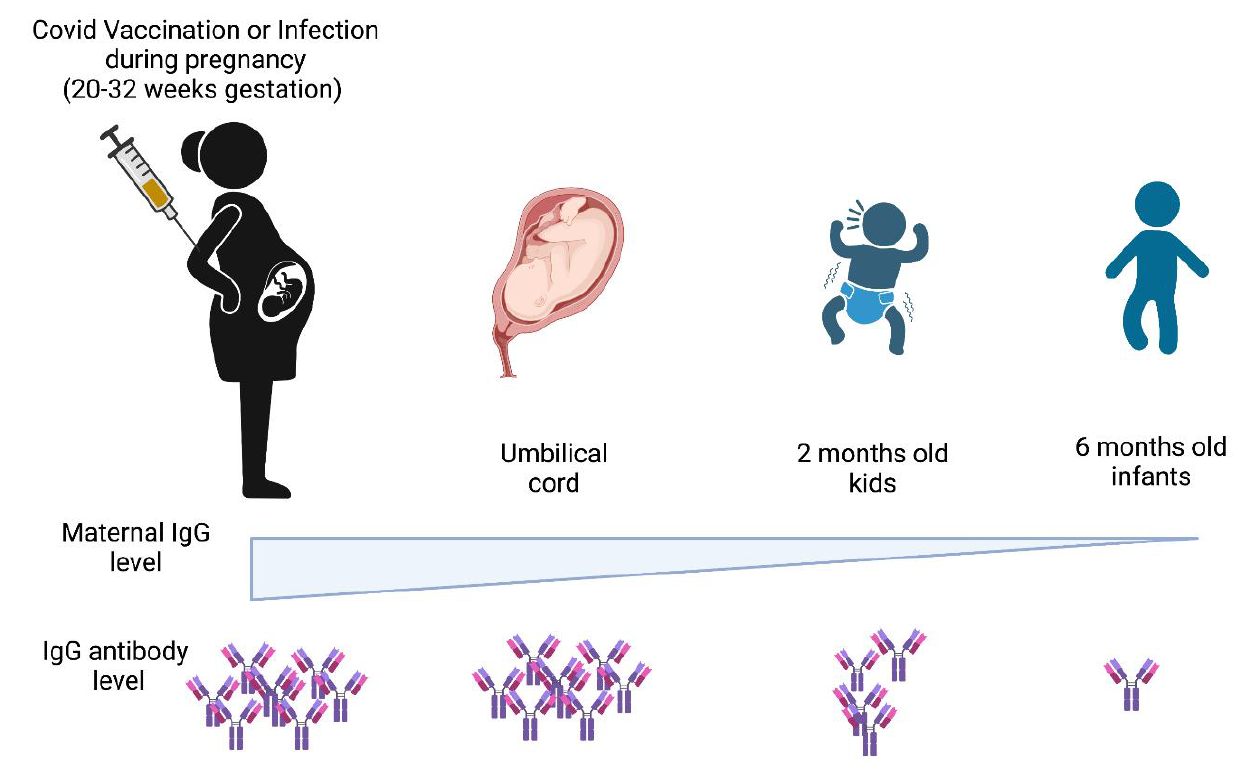
Figure 1. Levels of maternal IgG antibody transferred from mother to infant wanes during 0–6 months after birth. Maternal anti-SARS-CoV-2 IgG antibodies acquired either by natural infection or vaccination are transferred to the fetus via placenta. The level of maternal antibodies decreases with the infant’s age and lasts up to 6 months. SARS-CoV-2 infection or COVID-19 vaccination during 20–32 weeks of gestation generated the highest antibody titer in pregnant women. This gradually declines when tested in umbilical cord samples at the time of birth, and then further declines at 2 months after birth as observed in infant serum samples and reaches a minimal amount at the age of 6 months, as represented in Figure 1.